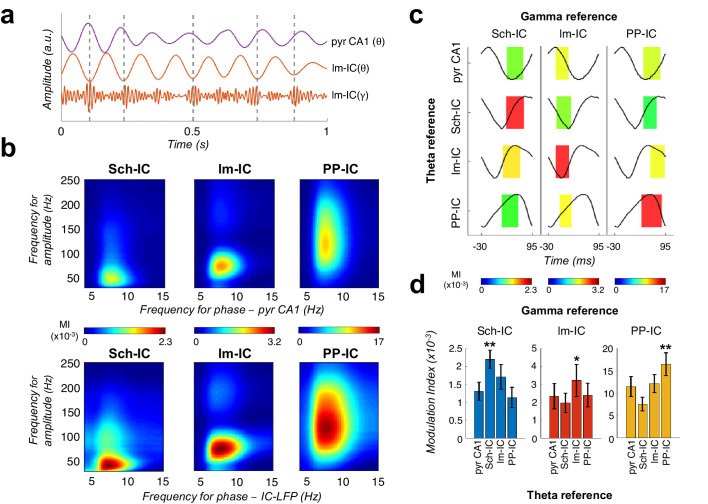
Theta-gamma coupling reflects pathway-specific interactions.(a) Representative theta- and gamma-filtered traces of lm-IC showing how the gamma envelope is phase-locked at the trough of the theta oscillation recorded in the same IC-LFP (highlighted with dashed lines), but not with the oscillation recorded in the CA1 pyramidal layer (pyr CA1). (b) Modulation strength (color coded MI) of gamma amplitude (30–250 Hz) in the IC-LFPs and the theta phase recorded in the pyr CA1 LFP (upper panels) and the pathway-specific thetas in the corresponding IC-LFPs (lower panels). (c) Interregional CFC across all gamma and theta oscillations recorded in the three IC-LFPs and pyr CA1. Each rectangle represents the MI between the theta phase and the gamma amplitude at a single specific frequency (gamma reference: slow/medium/fast gamma for Sch-IC/lm-IC/PP-IC). The location and width of the rectangles indicate the theta phase at which gamma amplitude is coupled, and the color indicates the MI (color scales at the bottom of each column). Theta waveforms (black traces) are extracted as the average of all theta cycles in the corresponding signals. The highest CFC strength (red rectangle) was always found between theta and gamma oscillations of the same pathway. (d) Maximum theta-gamma CFC corresponds to oscillations recorded in the same IC-LFP, higher than any between-pathway combination. Left/middle/right panel represents the MI (mean ± s.e.m.) between slow/medium/fast gamma recorded from Sch-IC/lm-IC/PP-IC, and the theta phase of all IC-LFPs and the LFP from pyrCA1. Significantly stronger MI values were found in all cases when theta phases were calculated from the corresponding pathway-specific generators, in contrast to pyr CA1 LFP, and when theta and gamma oscillations had the same origin (*/**p<0.05/0.01, one-way ANOVA of repeated measurements between MI with the same theta reference, followed by Bonferroni correction, F(1.182, 4.729)=36.16/F(1.133, 4.531)=8.649/F(1.555, 6.219)=35.32 for Sch-IC/lm-IC/PP-IC as theta reference, N = 5).